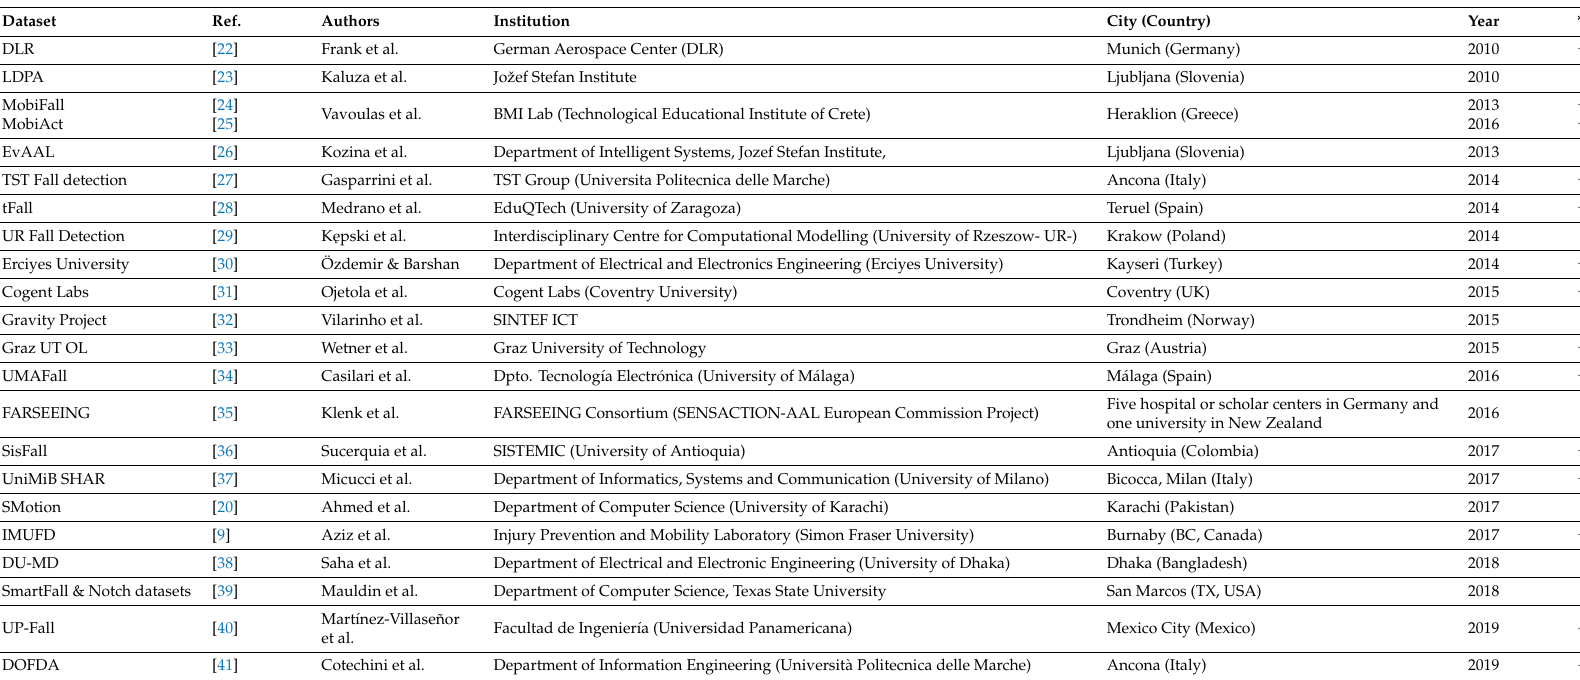
Table 1. List of the existing public datasets intended for the study of wearable fall detection systems. (* Note: